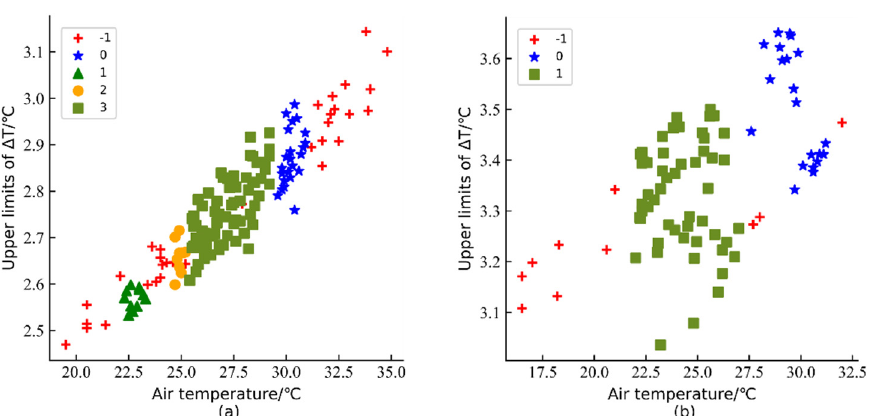
Figure 8. HDBSCAN clustering results for the upper limits of Δ T and Ta: ( a ) clustering results in the V stage; ( b ) clustering results in the R stage.